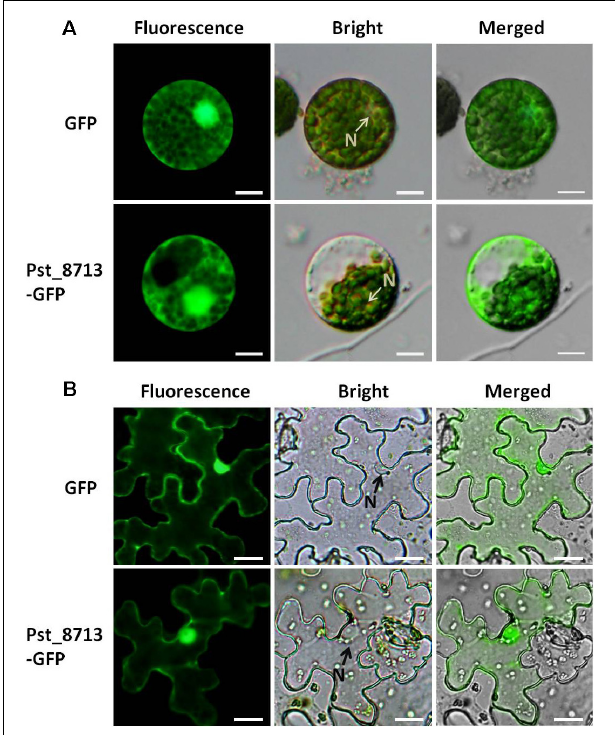
FIGURE 3 | Localization of Pst_8713 in cytoplasm and nucleus. (A) GFP and Pst_8713-GFP fusion proteins in wheat mesophyll protoplasts with PEG-mediated transformation. N, nucleus. Bar = 50 µ m. (B) Constructs of GFP and Pst_8713-GFP fusion proteins transformed into Agrobacterium tumefaciens and infiltrated into leaves of 6 weeks old Nicotiana benthamiana. N, nucleus. Bar = 10 µ